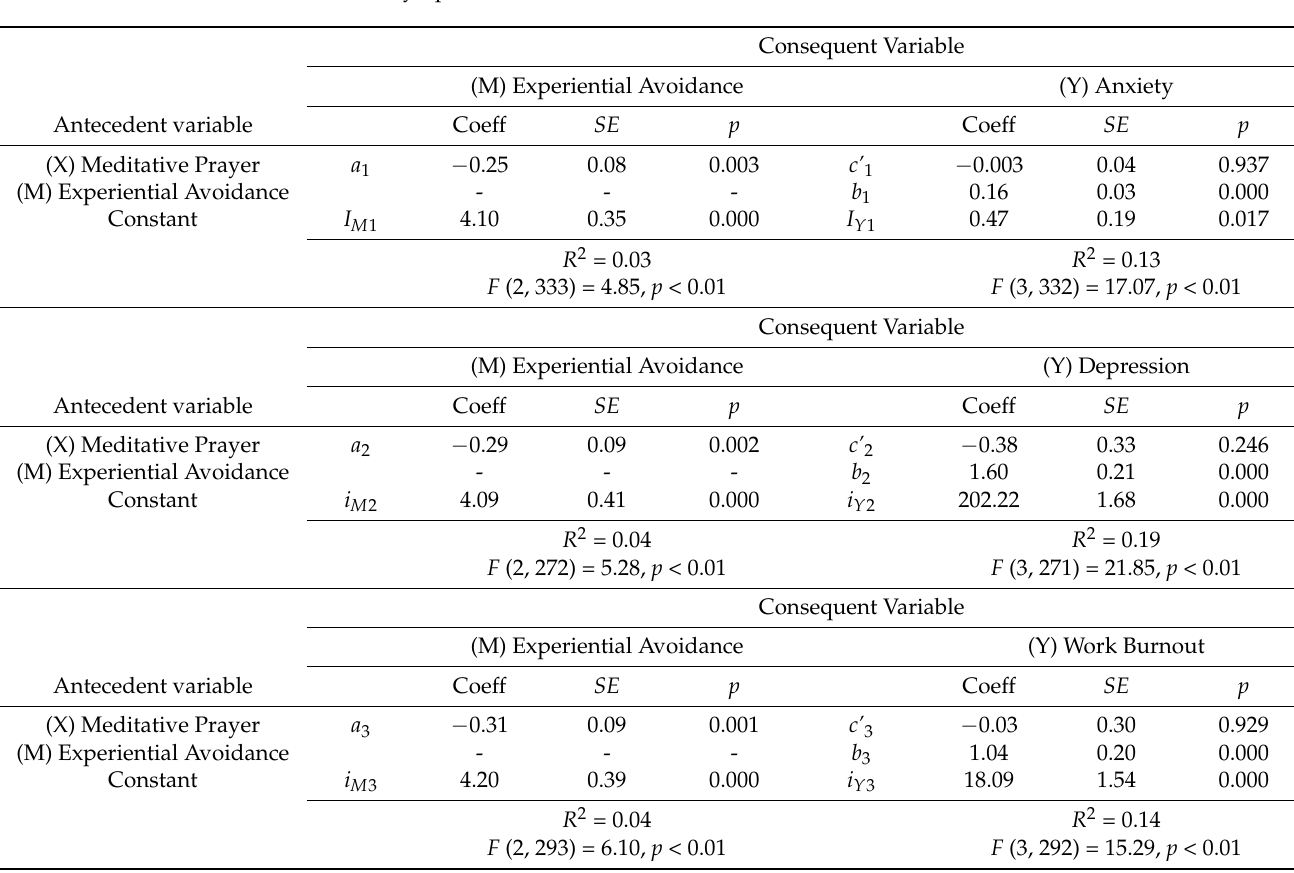
Table 6. Regression models involving meditative prayer, experiential avoidance, and mental health